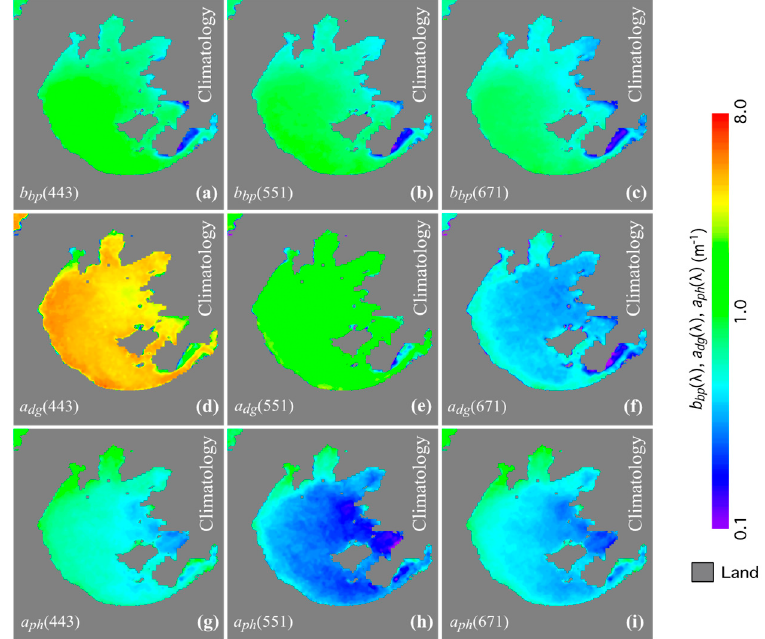
Figure 5. VIIRS-derived IOP climatology in Lake Taihu between 2012 and 2018 for (a–c) b bp ( λ ), (d–f) a dg ( λ ), and (g–i) a ph ( λ ) at the VIIRS bands of 443 nm (left column), 551 nm (middle column), and 671 nm (right column).